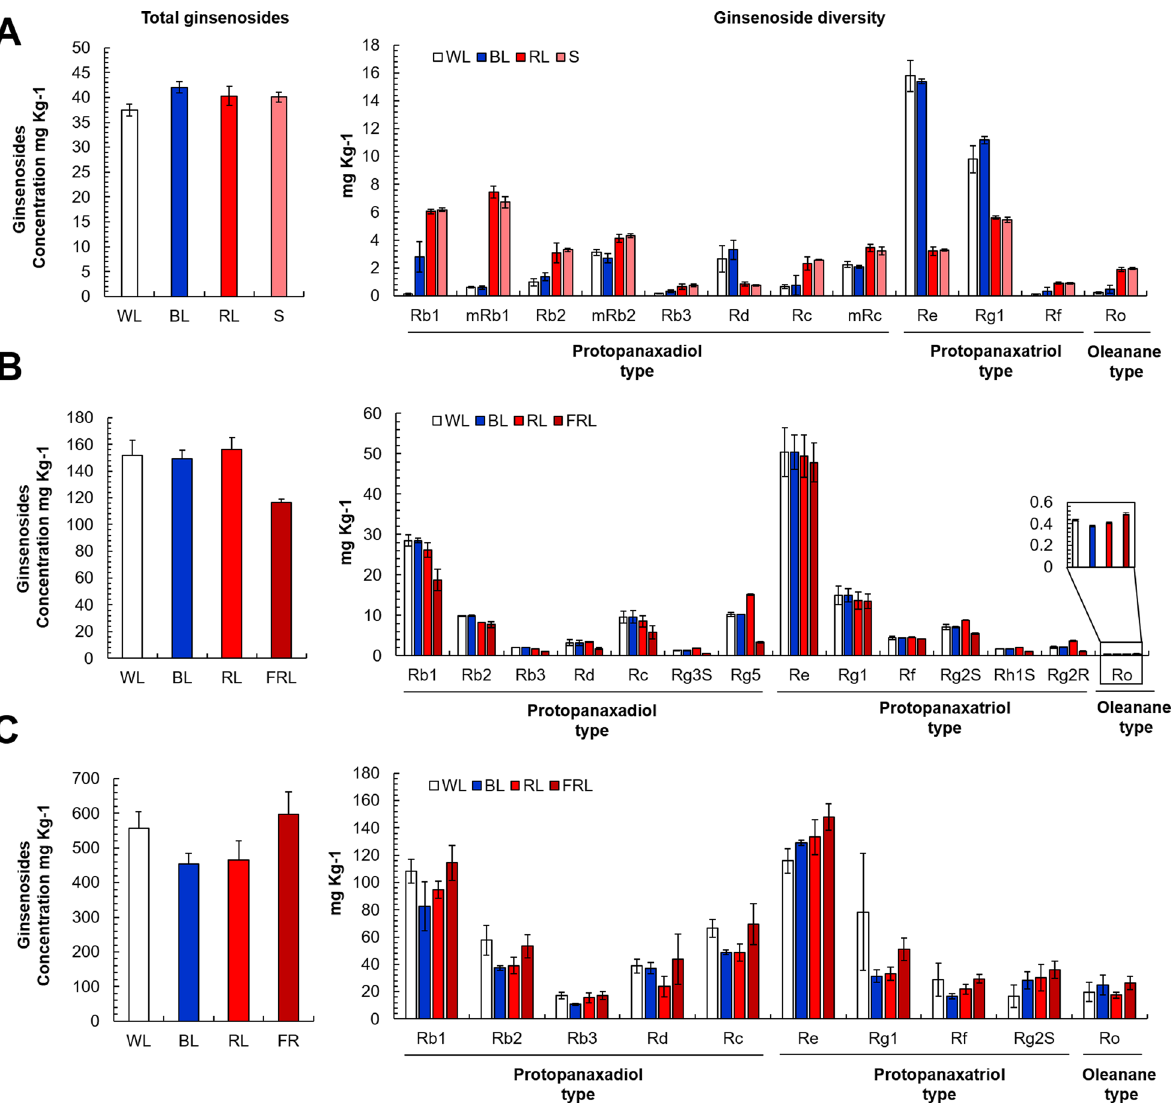
Fig. 4 UPLC quantification of ginsenoside diversity from plants exposed to various wavelengths of light. A One‑month‑old ginseng seedlings, B adventitious roots, and C 2‑year‑old plant after light treatment. WL: white light; BL: blue light; RL: red light; S: shade; FRL: far‑red